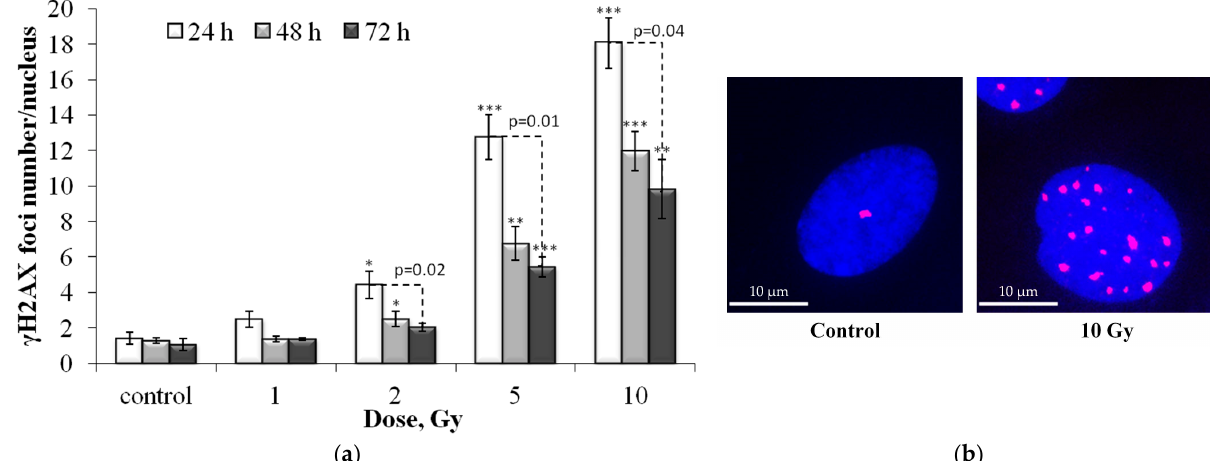
Figure 1. ( a ) Dose–dependent changes in the number of residual γ H2AX foci in human fibroblasts 24 h, 48 h and 72 h after irradiation. Data are means ± SE of three independent experiments. * p < 0.05; ** p < 0.01 and *** p < 0.001—compared with the corresponding time of control; ( b ) Representative microphotographs of immunocytochemically stained control and 10 Gy irradiated cells (24 h) showing nucleus (blue) and foci (red).